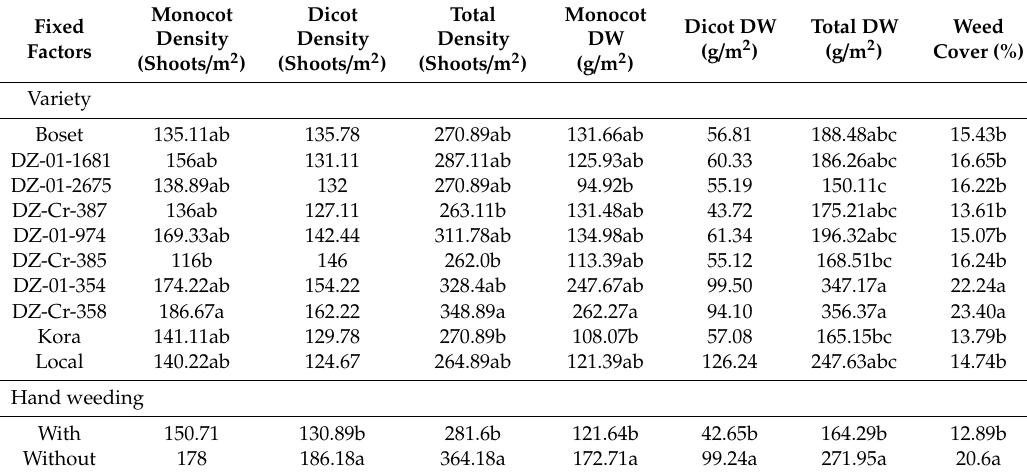
Table 7. Effects of teff varieties and hand weeding on weed assessments.